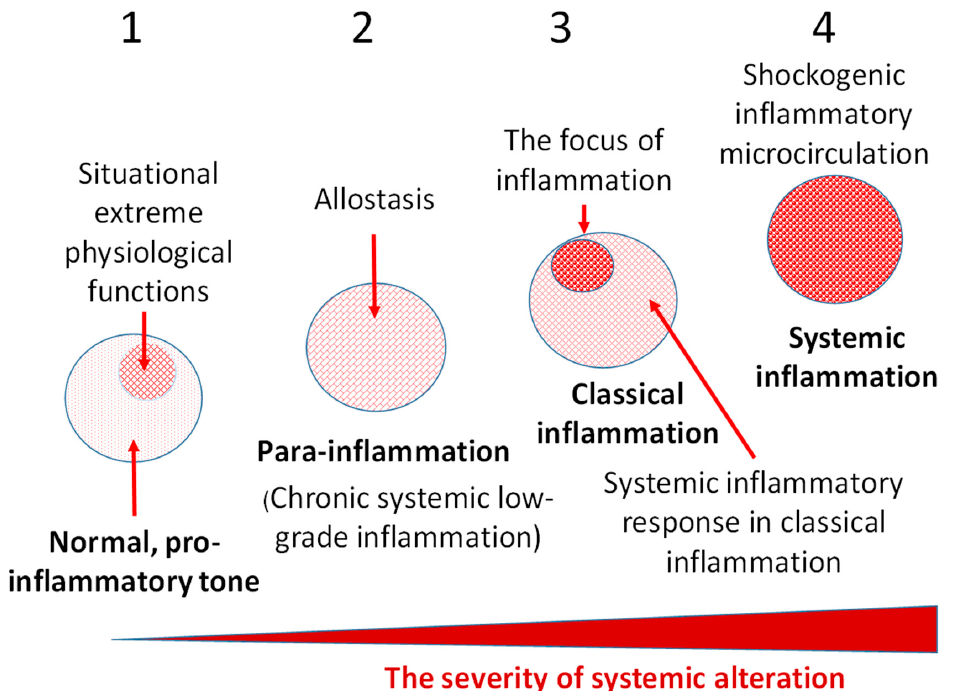
Figure 1. Variants of tissue pro-inflammatory stress. 1—Physiological variants of TS; 2—Non-classical low-grade inflammation (para-inflammation), which at systemic level may be manifest as stably altered homeostasis (allostasis); 3—Classical inflammation (the organism’s response to a significant local injury) is characterized by the presence of its attribute—a focus of inflammation and, in some cases, a systemic inflammatory response aimed at resourcing the focus of inflammation; 4—Life- critical systemic inflammation, the key phenomenon of which is a systemic microvascular response comparable in intensity to the local response in the focus of classical inflammation.